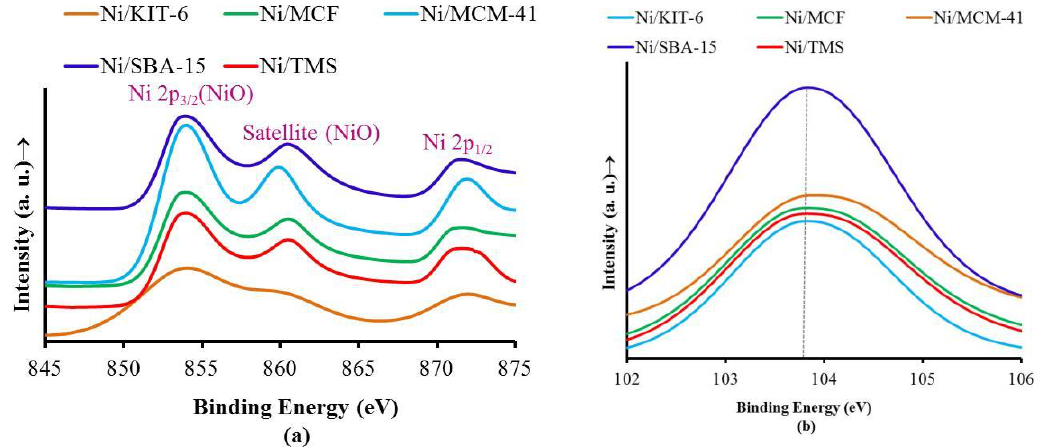
Figure 5. ( a ) Ni 2p and ( b ) Si 2p XPS spectra of the Ni / SiO 2 catalysts.